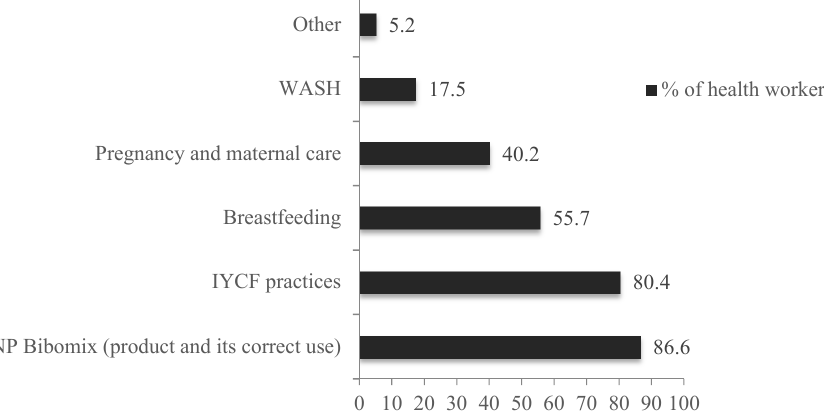
Figure 2. Counseling topics that were provided to the caregivers, as reported by the health workers.